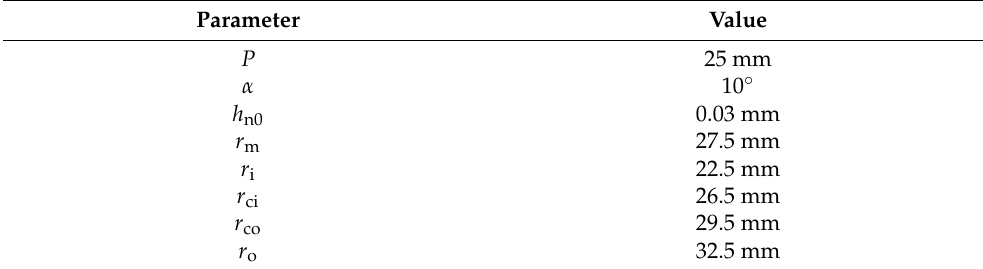
Table 2. Main geometric parameters of the